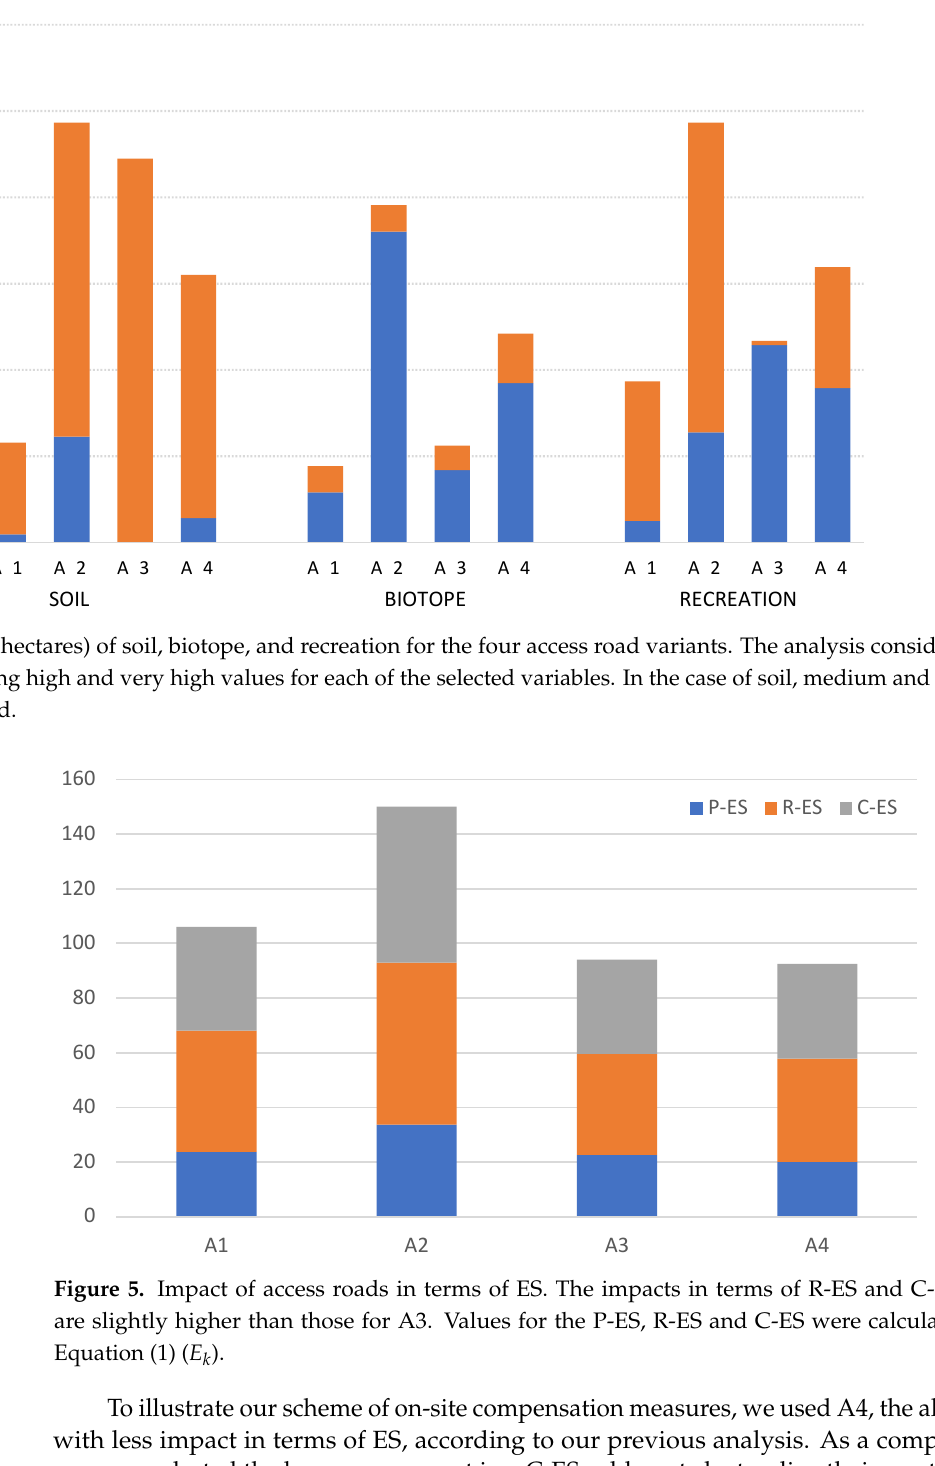
Figure 5. Impact of access roads in terms of ES. The impacts in terms of R-ES and C-ES for A4 are slightly higher than those for A3. Values for the P-ES, R-ES and C-ES were calculated using Equa- tion 1 (E k ).